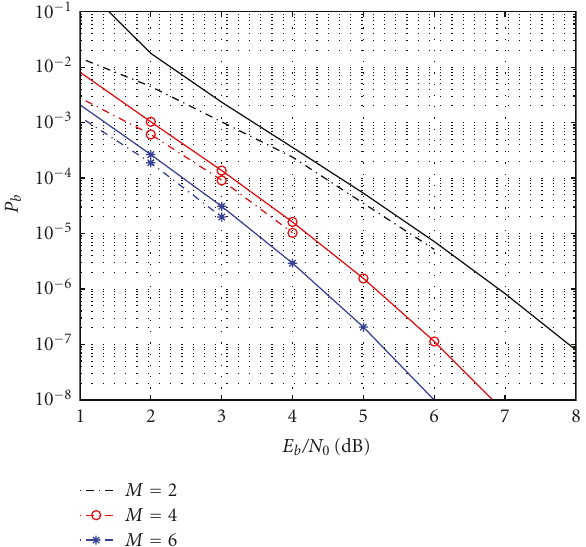
Figure 6: Bit-error probability of convolutionally coded SC with di ff erent number of diversity branches in Nakagami fading wih m = 2 (solid: bound, dashed: simulation).